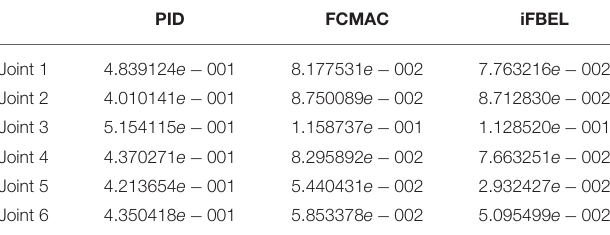
TABLE 6 | The accumulated RMSE value of each joint of the biped robot at ρ 2 =